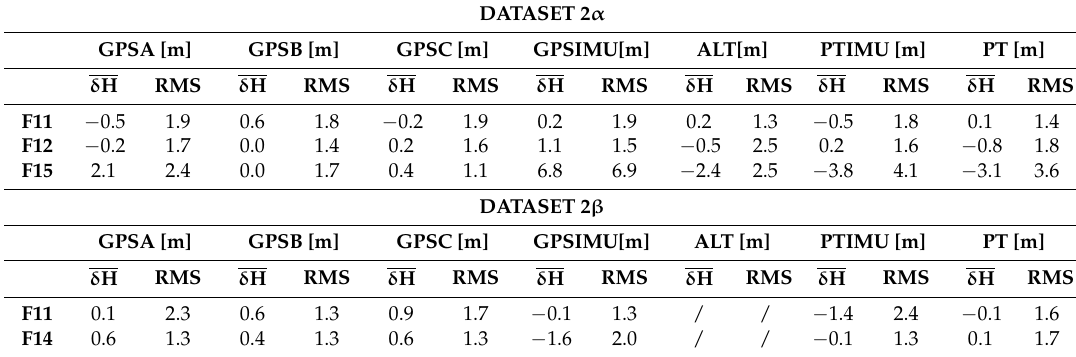
Table 4. Average residuals δ H J and RMS ( δ H J ) for DATASET 2. Linear regression data for each couple of sensors in the five cases are reported in Tables A1–A5.